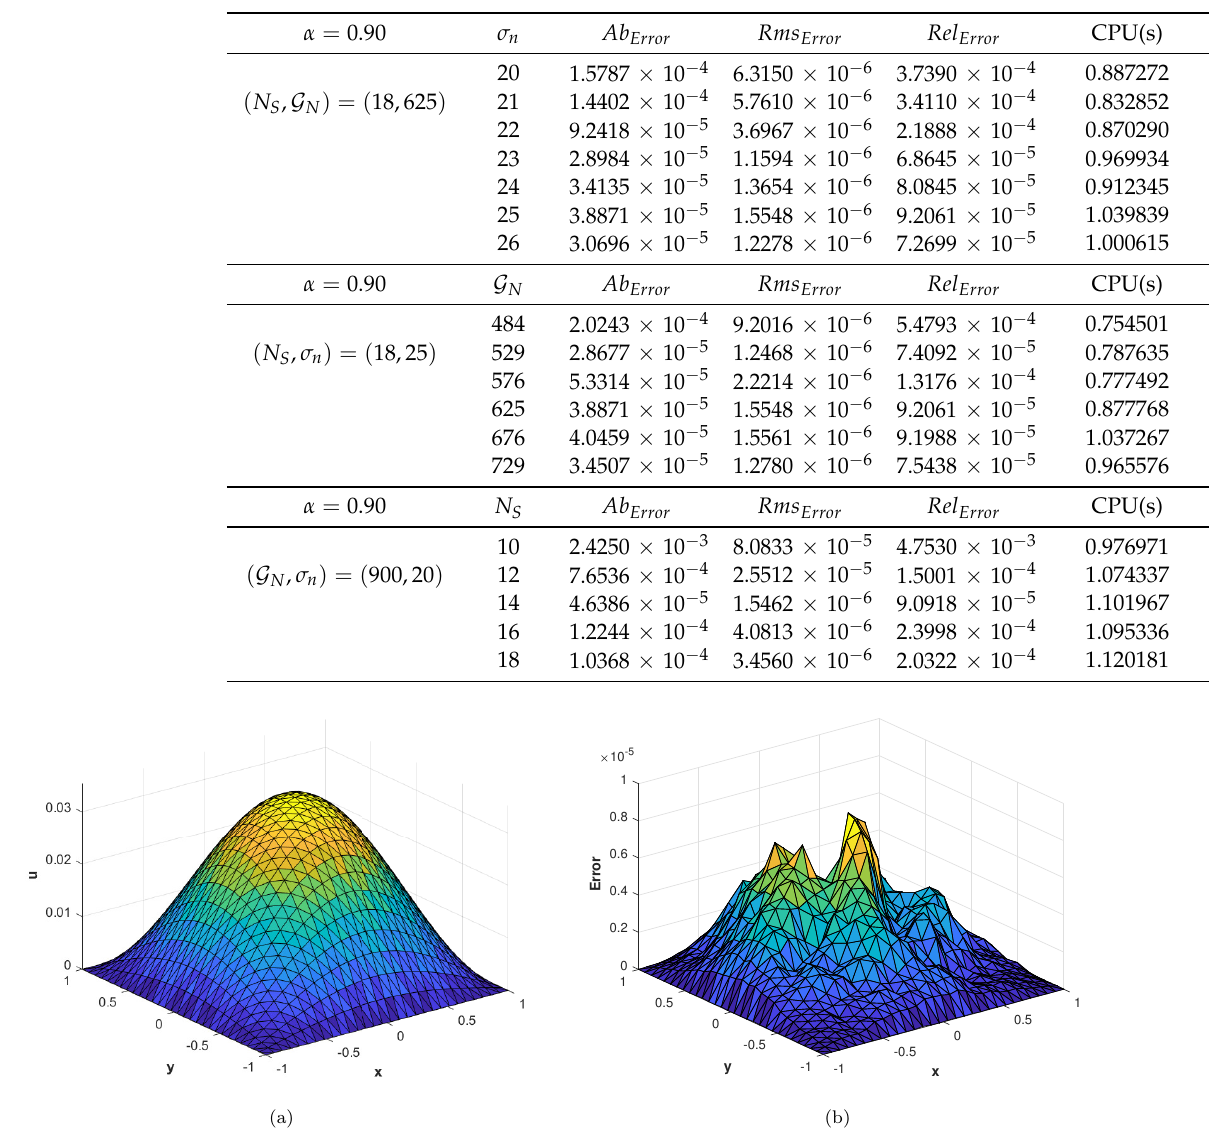
Figure 12: (a) Numerical solution of problem 3. (b) Ab Error of the proposed method with Figure 12. ( a ) Numerical solution of problem 3. ( b ) Ab Error of the proposed method with 18 , σ n = 20 at T = 1 corresponding to problem 3. N S = 18, σ n = 20 at T = 1 corresponding to problem 3.